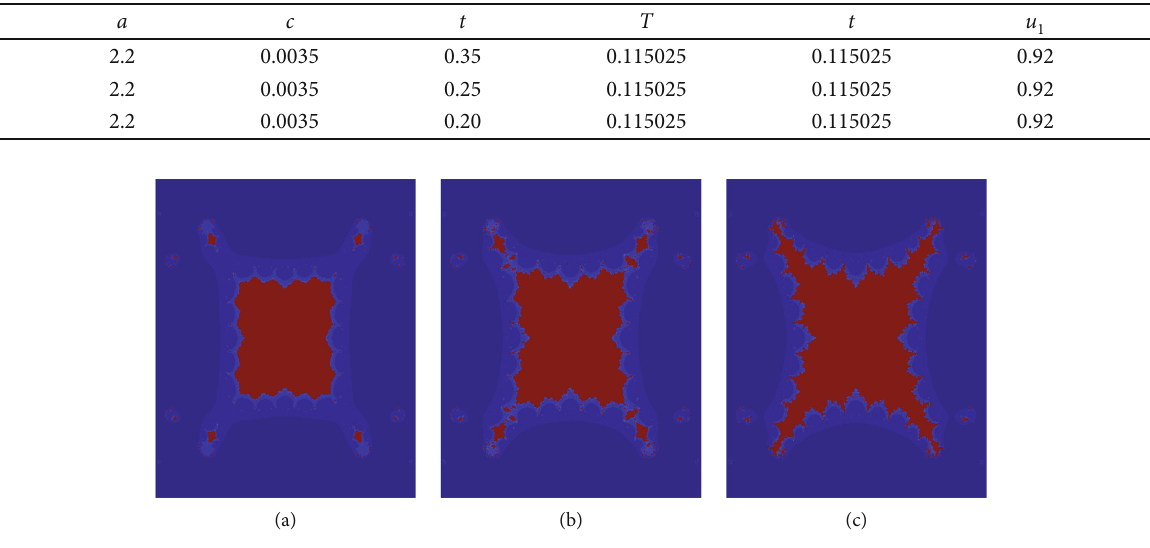
Table 5: Parameters for generation of quintic Julia set for di ff erent values of t .